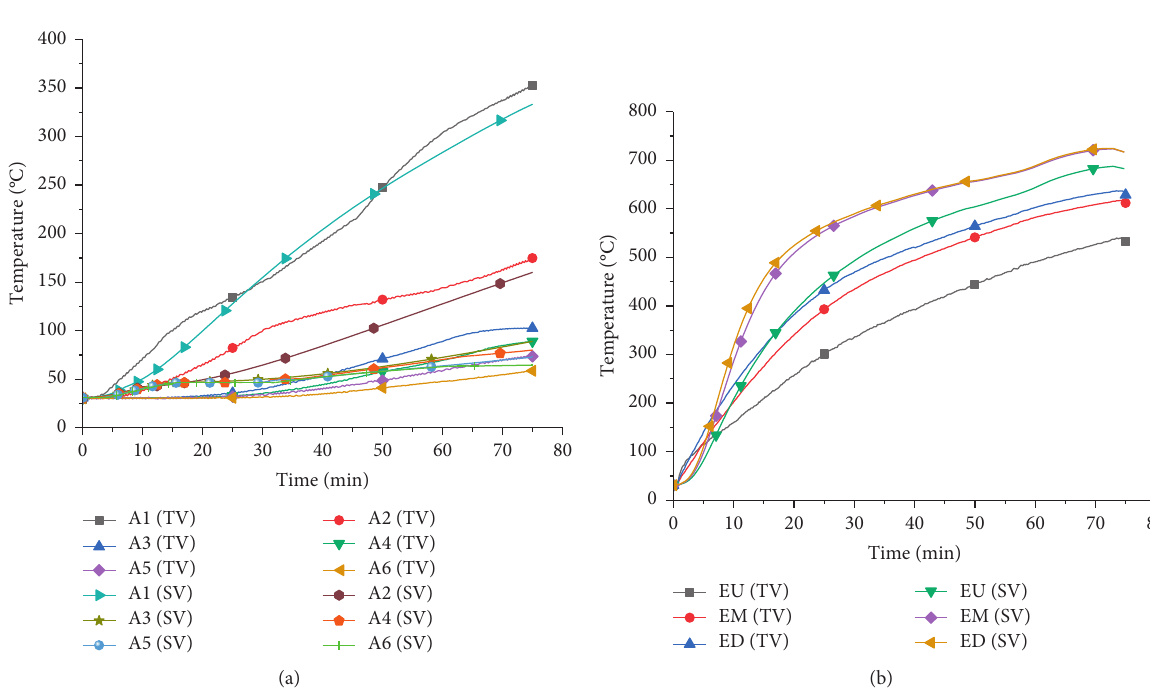
Figure 14: Comparison of temperature changes in SCB-2 for (a) concrete slab and (b) steel beam (note: TV � tested value and SV � simulated value; the same applies hereafter).